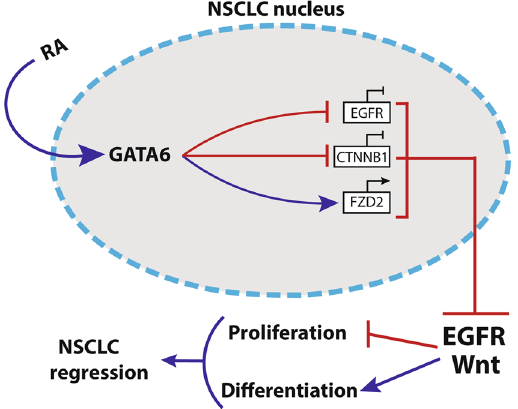
Figure 7. A working model of the signaling mechanisms regulated by RA to induce NSCLC regression. RA treatment increases GATA6 expression levels in differentiated NSCLC cells. GATA6 acts (1) by inhibiting EGFR and CTNNB1 transcript, and (2) by activating the expression of the Wnt inhibitor FZD2 . These molecular effects lead to the down-regulation of EGFR and Wnt signaling pathways, by arresting tumor cell proliferation and promoting cell